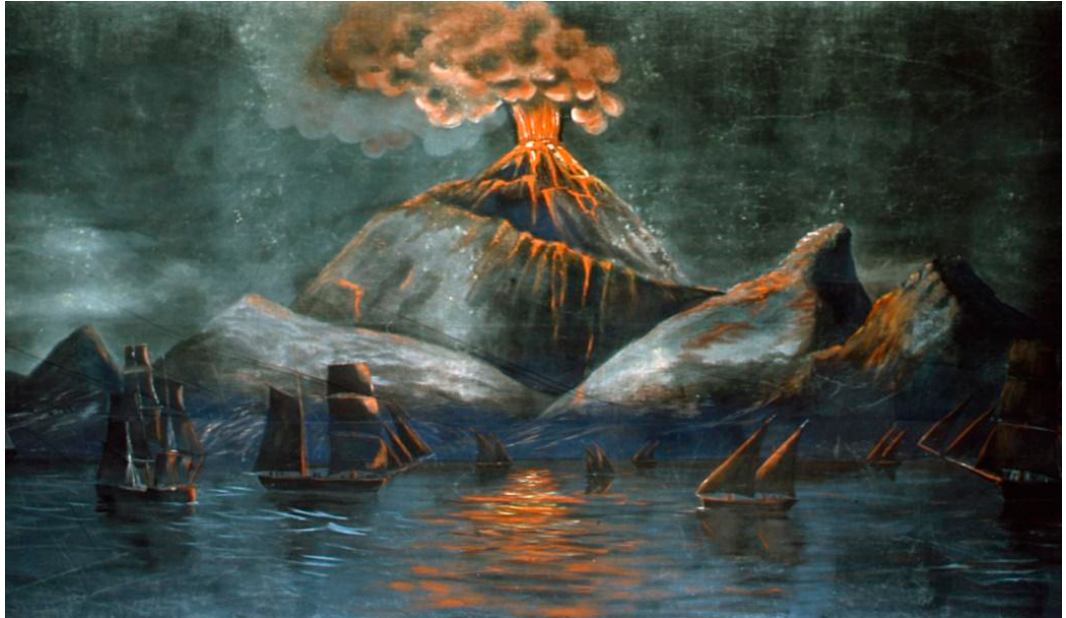
Figure 3. Illustration of the erupting volcano of the Island of Fogo in 1847 in the Grand Panorama of a Whaling Voyage Round the World by Caleb Purrington and Benjamín Russell, 1847–1848. Courtesy of the New Bedford Whaling Museum.